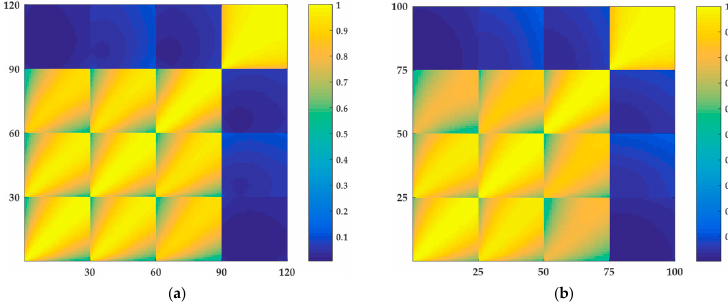
Figure 9. Performance comparison for multiple scales’ classification between the proposed MSGF and the reference MPGF techniques obtained on: ( a ) Zh1 and ( b ) Zh2.